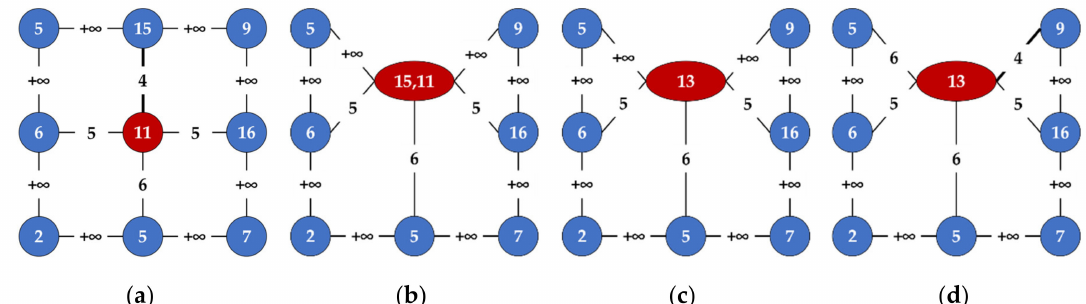
Figure 1. Illustration of the aggregation process of superpixels. The vertices represent pixels and the edges represent similarities. ( a )The vertex 15 is the nearest neighbor of the tree (red vertex 11), ( b ) the tree aggregates the nearest neighbor, ( c ) update the average attribute of the tree, ( d ) expand the search scope of the tree and find the next nearest neighbor(vertex 9).